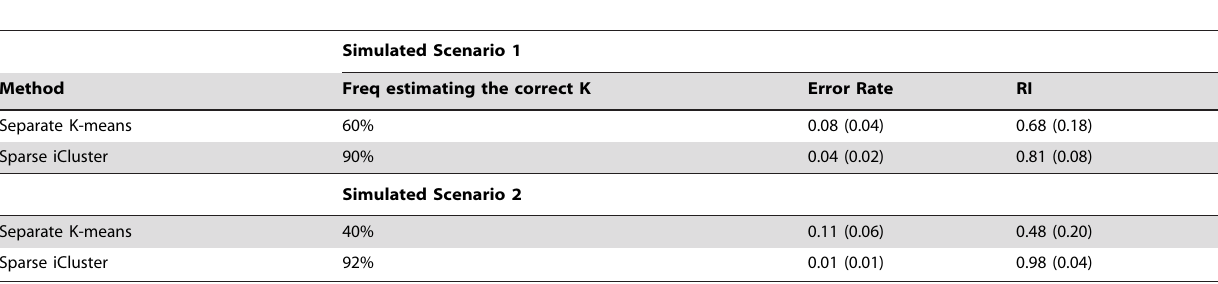
Table 1. Comparing separate clustering and iCluster performance using